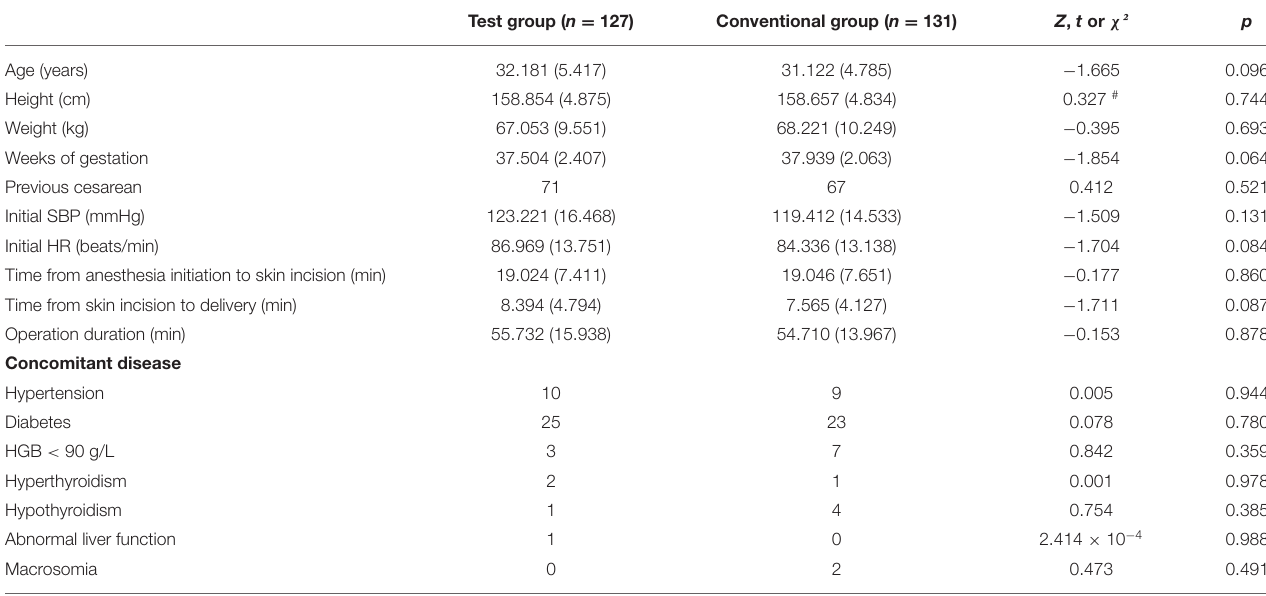
TABLE 2 | Parturient